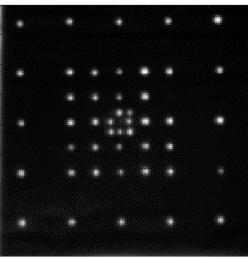
Figure 5. A sample cropped image of the LED board captured by one of the cameras at 14:50 local time (UTC—4) on 27 June 2019.